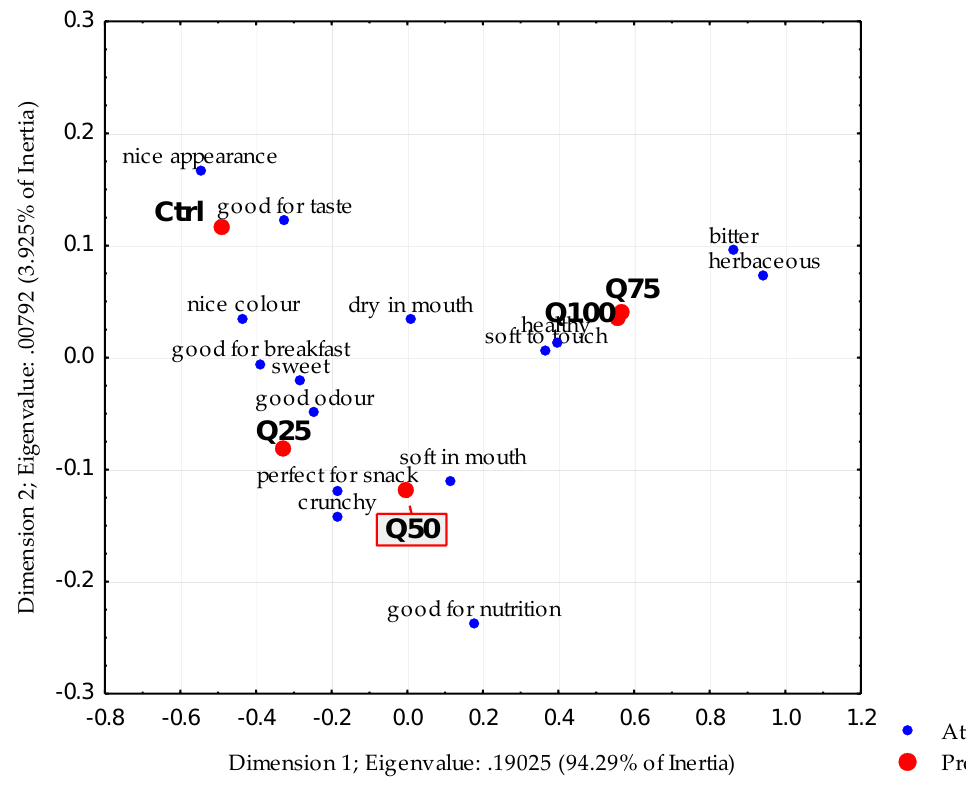
Figure 1. Correspondence analysis of ladyfinger biscuits made with RF only or at different QF substitution rates.